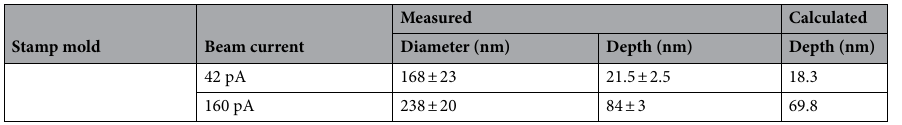
Table 2. Dimensions of the big and small nanopillars milled in the stamp mold (data reliability 95%) with theoretically calculated depth lengths.